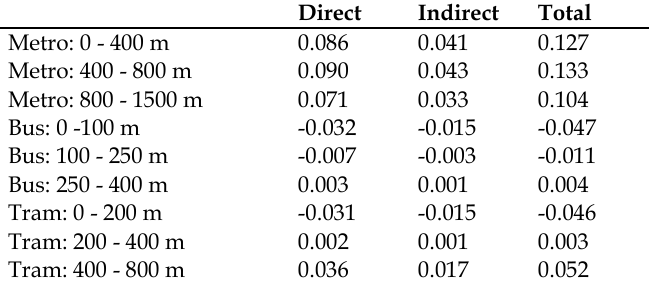
Table 5. Direct, indirect and total effects derived for SAR